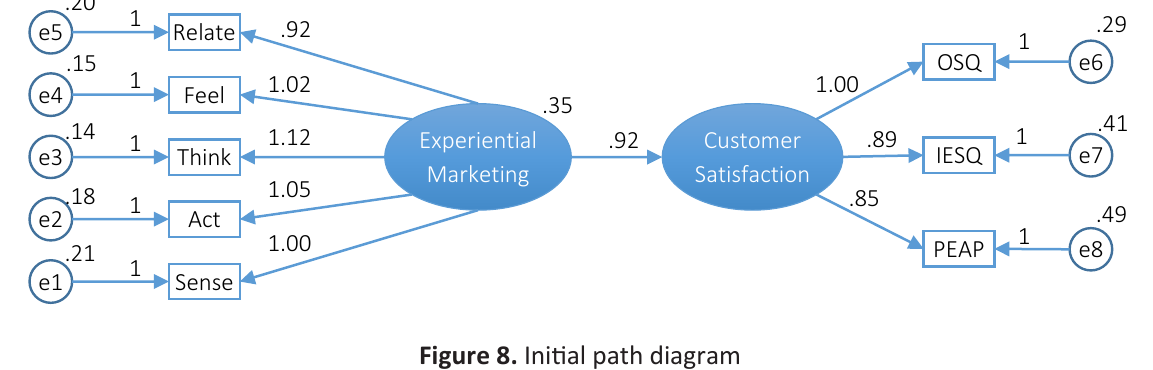
Figure 8. Initial path